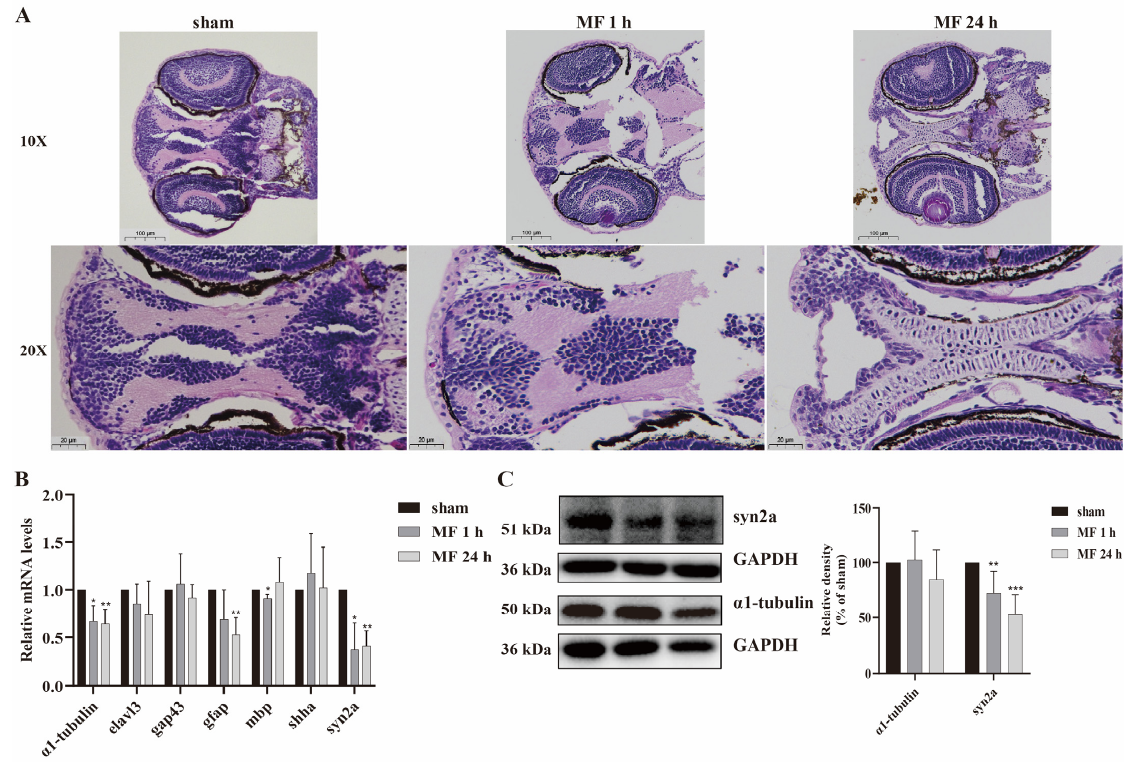
Figure 2. 50-Hz MF exposure caused neurodevelopmental toxicity in zebrafish larvae. ( A ) MF exposure impacted the brain tissue morphology of zebrafish; ( B ) Exposure to MF decreased the